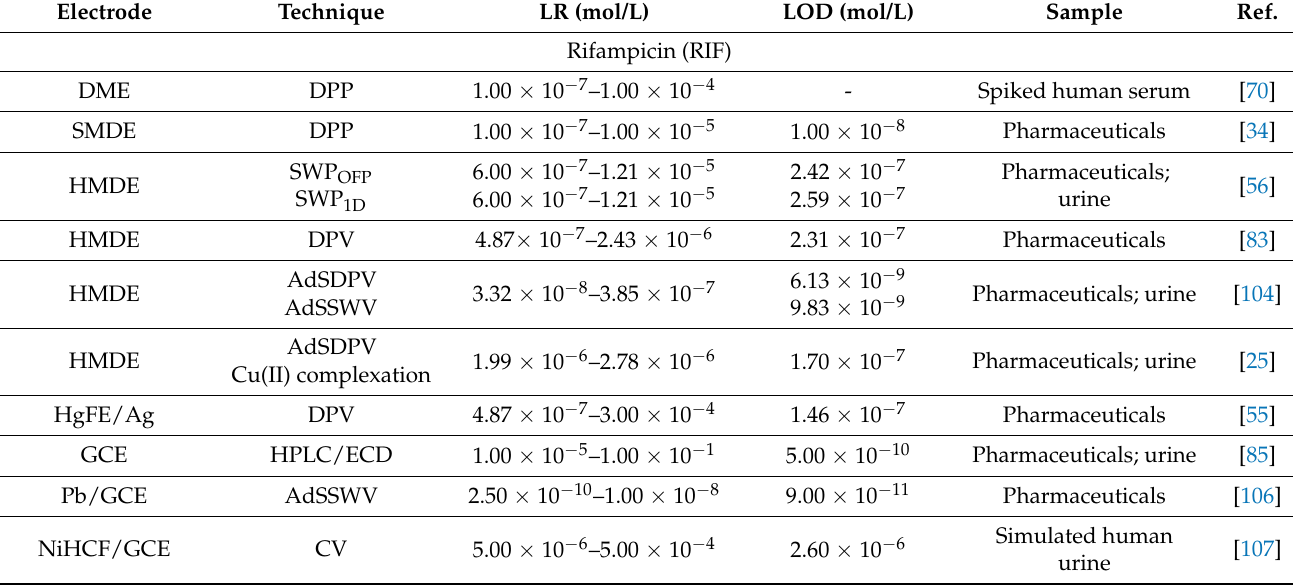
Table 1. The performance characteristics of electrochemical sensors reported in the literature for rifamycins